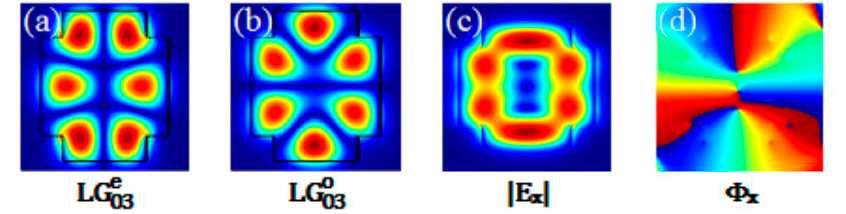
Figure 5. HG-similar component mode field distributions in the designed waveguide for l = ±3 OAM mode: ( a ) LG (cid:2868)(cid:2871)(cid:3032) and; ( b ) LG (cid:2868)(cid:2871)(cid:3042) modes. Field (Ex, horizontal component) and phase distributions of the resulting OAM mode: ( c ) electric field and ( d ) phase distributions.